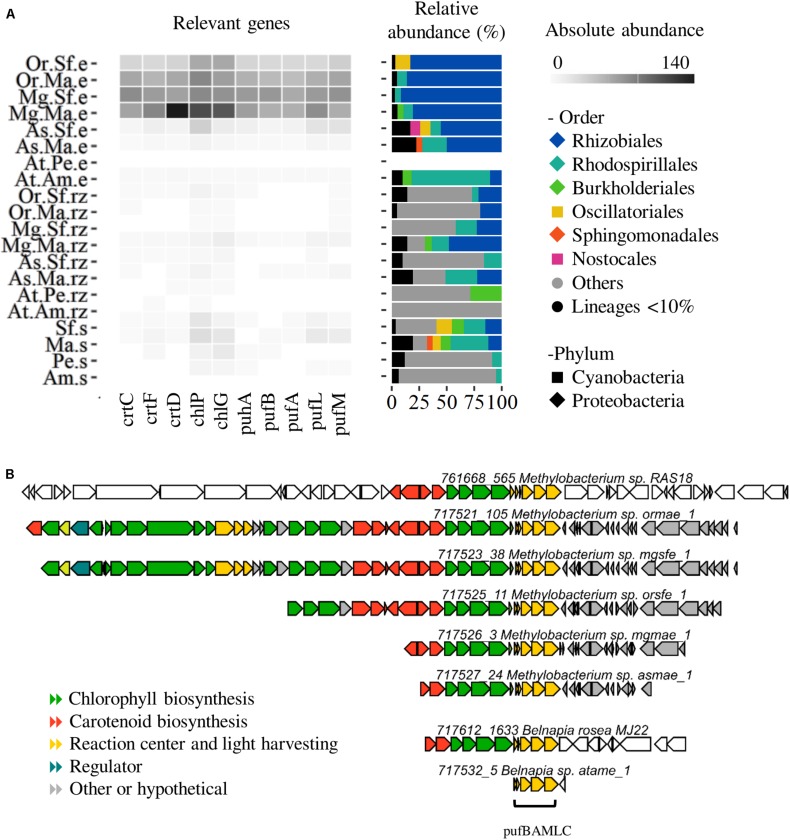
Aerobic anoxygenic phototrophs (AAP) profiling. (A) Abundance and taxonomic profile of phyllosphere enriched genes (pufABLM, puhA), bacteriochlorophyll biosynthesis genes (chlPG) and carotene biosynthesis genes (crtCDF). (B) AAP clusters of Methylobacterium and Belnapia scaffolds. Species: At, A. tequilana; As, A. salmiana; Mg, M. geometrizans; Or O. robusta. Sites: Am, Amatitán; Pe, Pénjamo; Ma, El Magueyal; Sf, San Felipe. Compartment: s, bulk soil; rz, rhizosphere; e, phyllosphere. Others: taxa not present in the phyllosphere. Lineages < 10% – low abundant taxa.